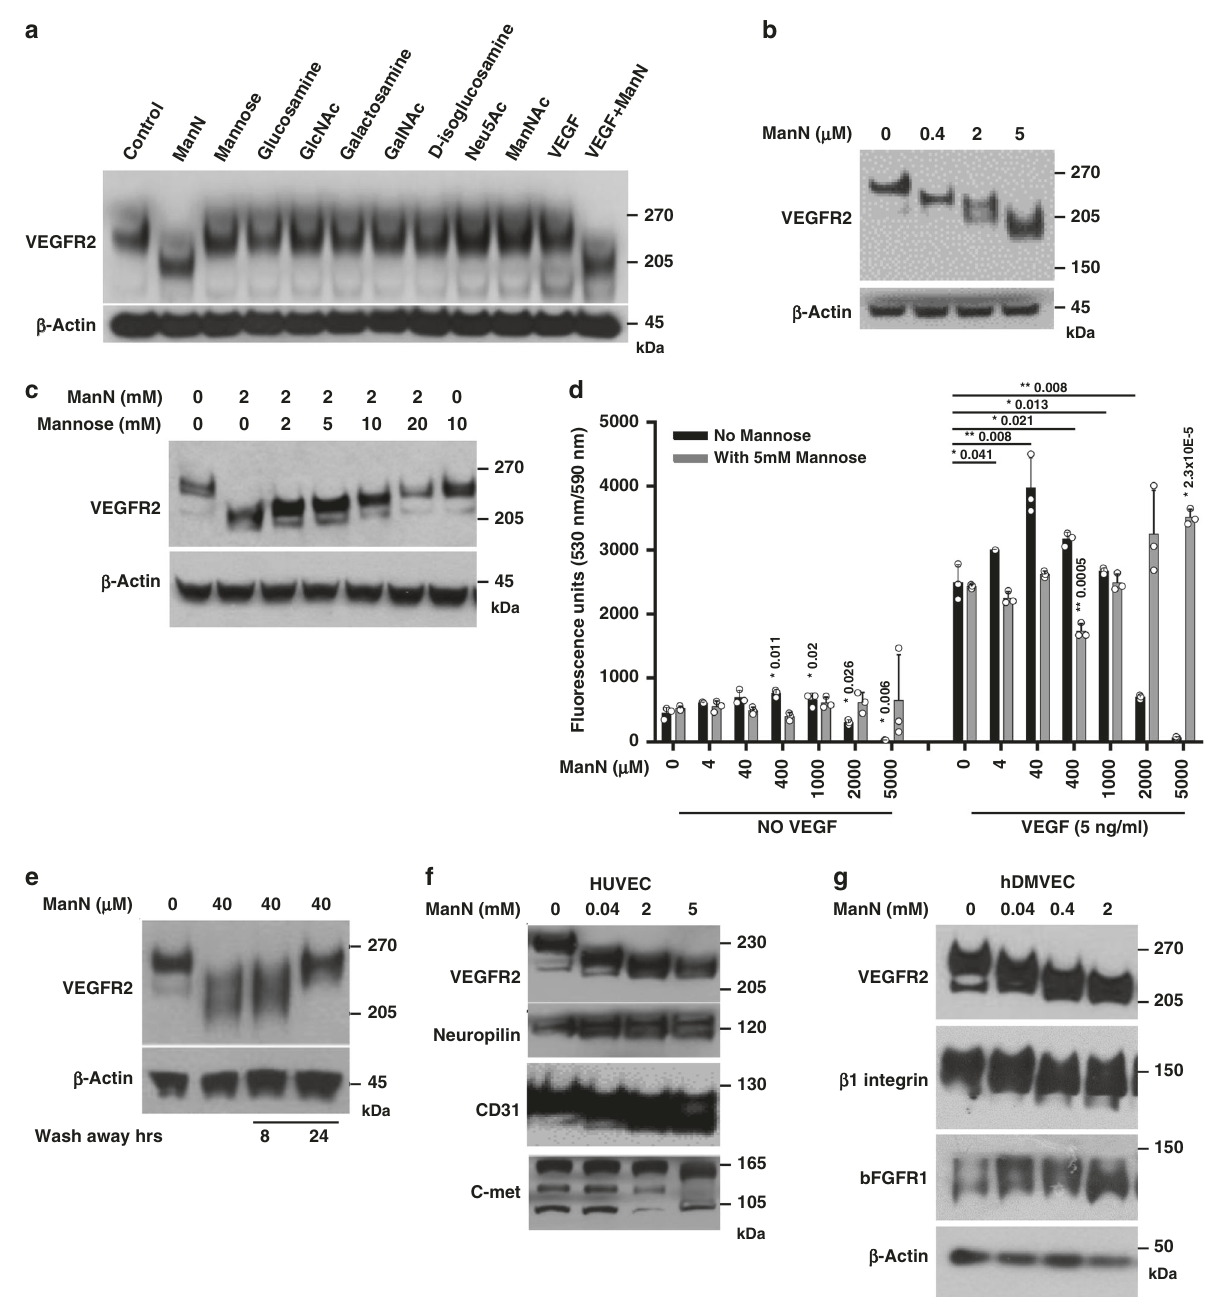
Fig. 4 ManN affects protein glycosylation. a Reduction of VEGFR2 molecular mass following ManN treatment. BCECs were treated with various hexosamines, their derivatives, and monosaccharides at 40 μ M or with VEGF at 5 ng/ml for 24 h. VEGFR2 western blot analysis was performed. b Dose- dependent effects of ManN on VEGFR2 molecular mass in BCECs. c Mannose could dose-dependently reverse the effect of 2 mM ManN on VEGFR2 molecular mass change, whereas mannose alone had no effect even at 10 mM. d 5 mM mannose could completely reverse the bell-shaped effects of ManN on BCEC proliferation with or without 5 ng/ml VEGF. BCECs plated in 96 wells were allowed to attach, followed by ManN addition. Two hours later, cells were treated with different concentrations of Mannose, with or without VEGF. Six days later, cell proliferation was quanti fi ed using AlamarBlue ® . n = 3 independent samples. e Effects of ManN are reversible. BCECs, after treatment with 40 μ M ManN for 24 h, were washed three times with low-glucose DMEM. Cells were kept in low-glucose DMEM for additional 8 or 24 h. VEGFR2 western blot analysis was performed. f Reduction of molecular mass of VEGFR2, Neuropilin-1, CD31, and c-met in HUVEC following ManN treatment at various concentrations. g Reduction of molecular mass of VEGFR2, β 1 integrin, and bFGFR1 in hDMVECs by ManN at various concentrations. β -actin served as the loading control. Data are means + / − SD, asterisks denote a signi fi cant difference compared with the control. For each study, a representative experiment is shown from two to fi ve independent studies. Statistical analysis was done by two-tailed, two-sample unequal variance t test. * p < 0.05, ** p < 0.01. Data are provided as a Source data fi